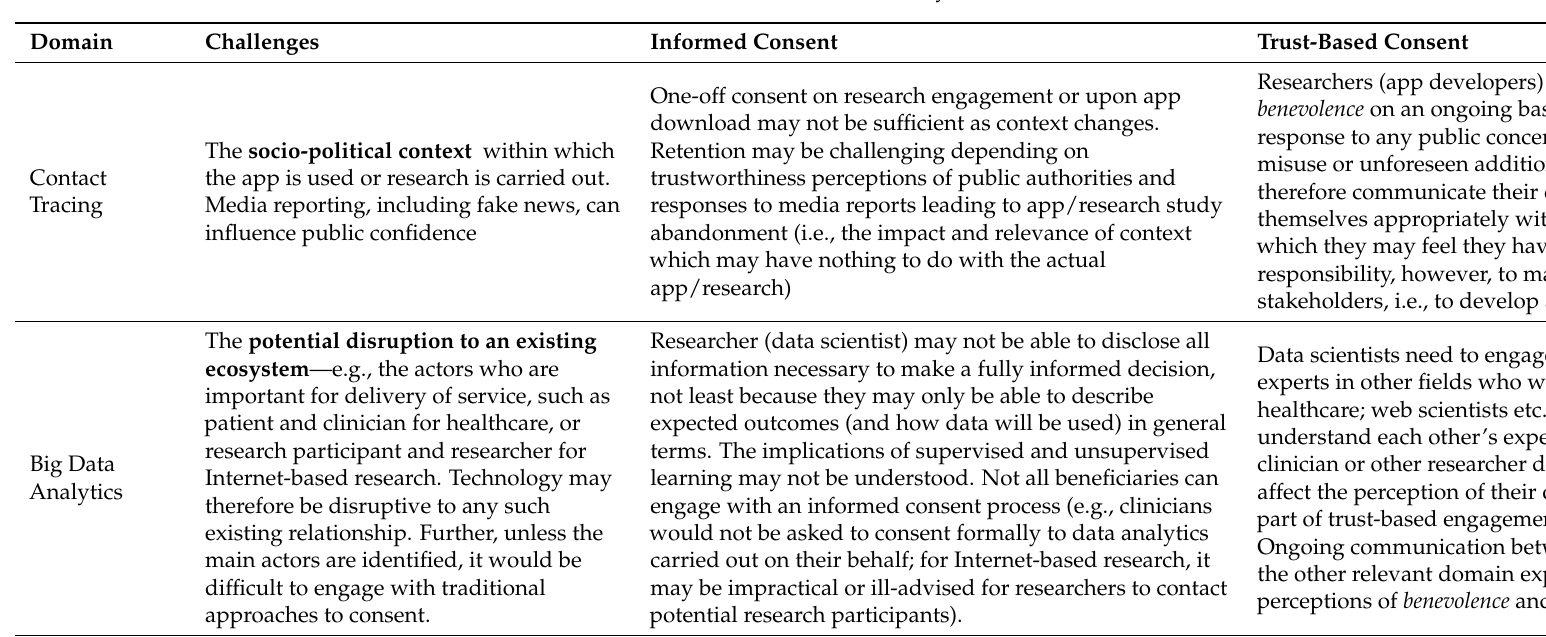
Table A1. Summary of Issues across